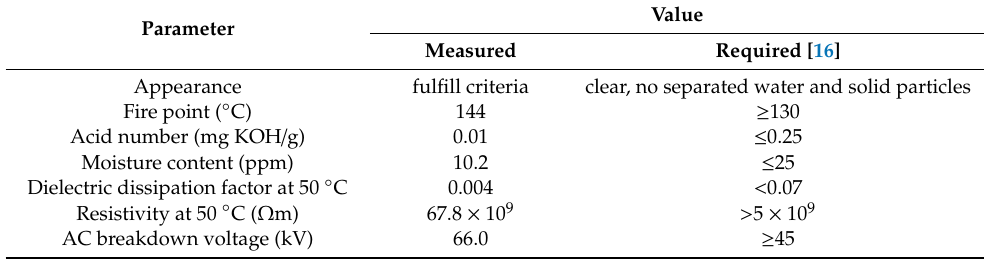
Table 4. Results of the measurements of oil sample taken from 30 MVA, 110 / 10.5 kV power transformer.